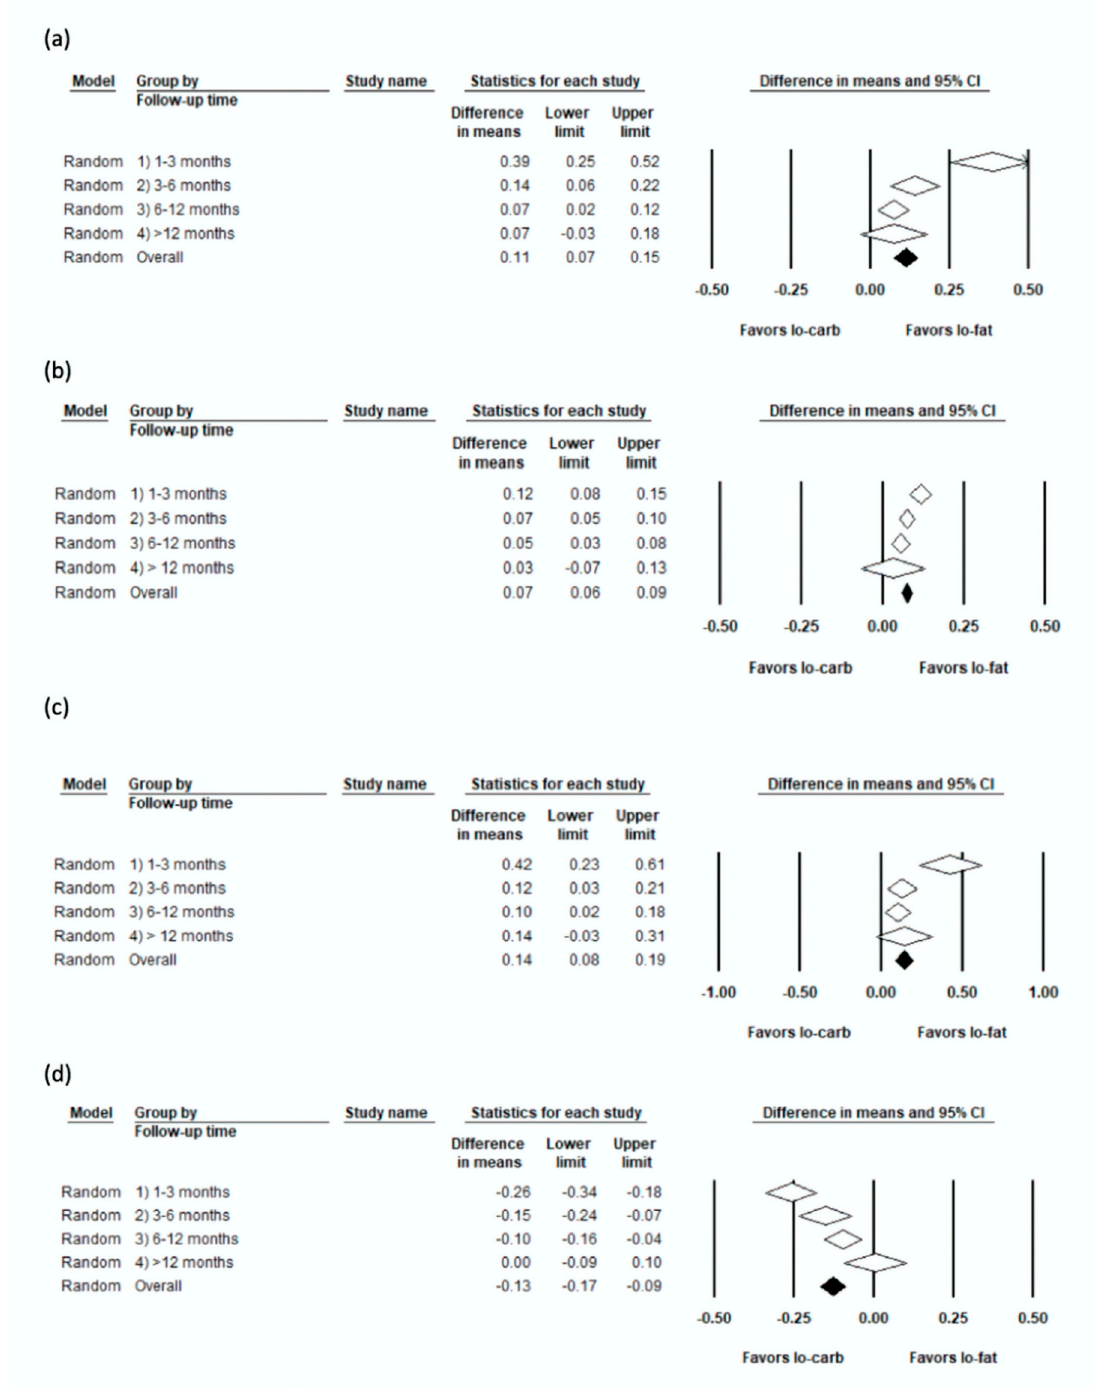
Figure 3. Forest plots showing weighted mean differences (WMD) and 95% CI across all studies and time periods for ( a ) Low-density lipoprotein cholesterol (LDL) cholesterol, ( b ) High-density lipoprotein cholesterol (HDL) cholesterol, ( c ) Total cholesterol, ( d ) Triglycerides.